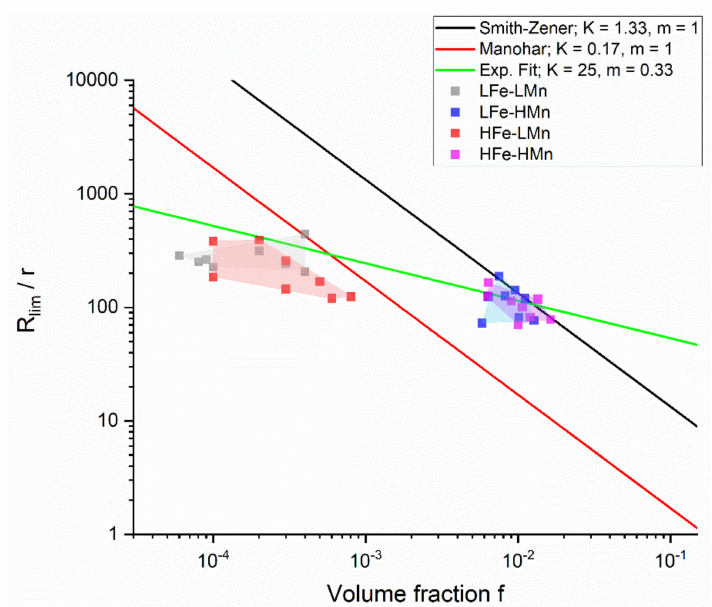
Figure 7. Comparison of the Zener limiting grain size calculated from the models of Smith–Zener and Manohar [26,28,33] to the experimentally observed data for the four different alloys, including the best